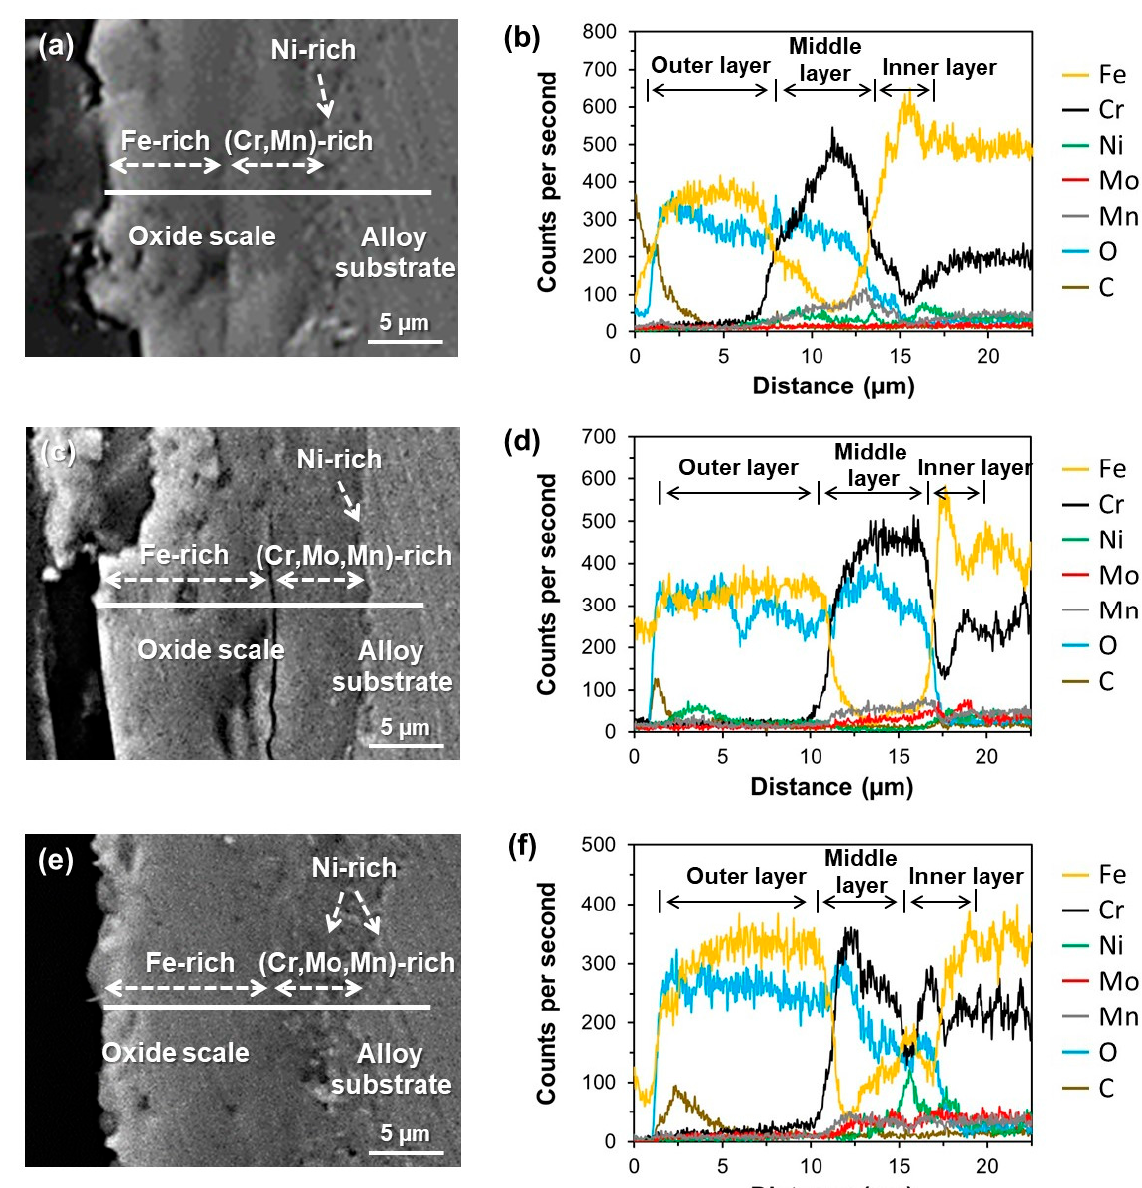
Figure 4. Cross-sectional SEM images and EDS line-scan analyses corresponding to ( a , b ) SS301, ( c , d ) DS2205, and ( e , f ) DS2507 samples exposed to molten salts for 1000 h.